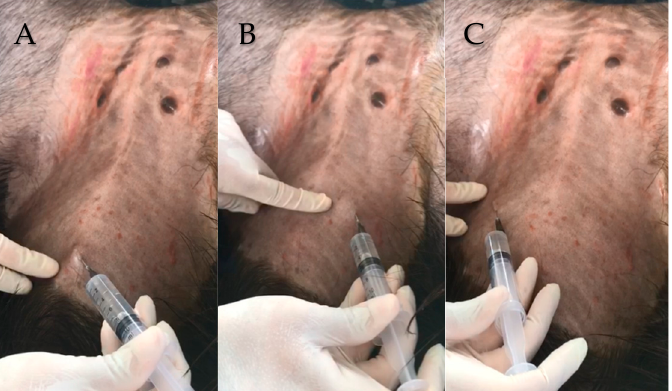
Figure 2. Performing local anesthesia, in the places where the first ( A ), second ( B ), and third ( C ) laparoscopic ports were to be established.